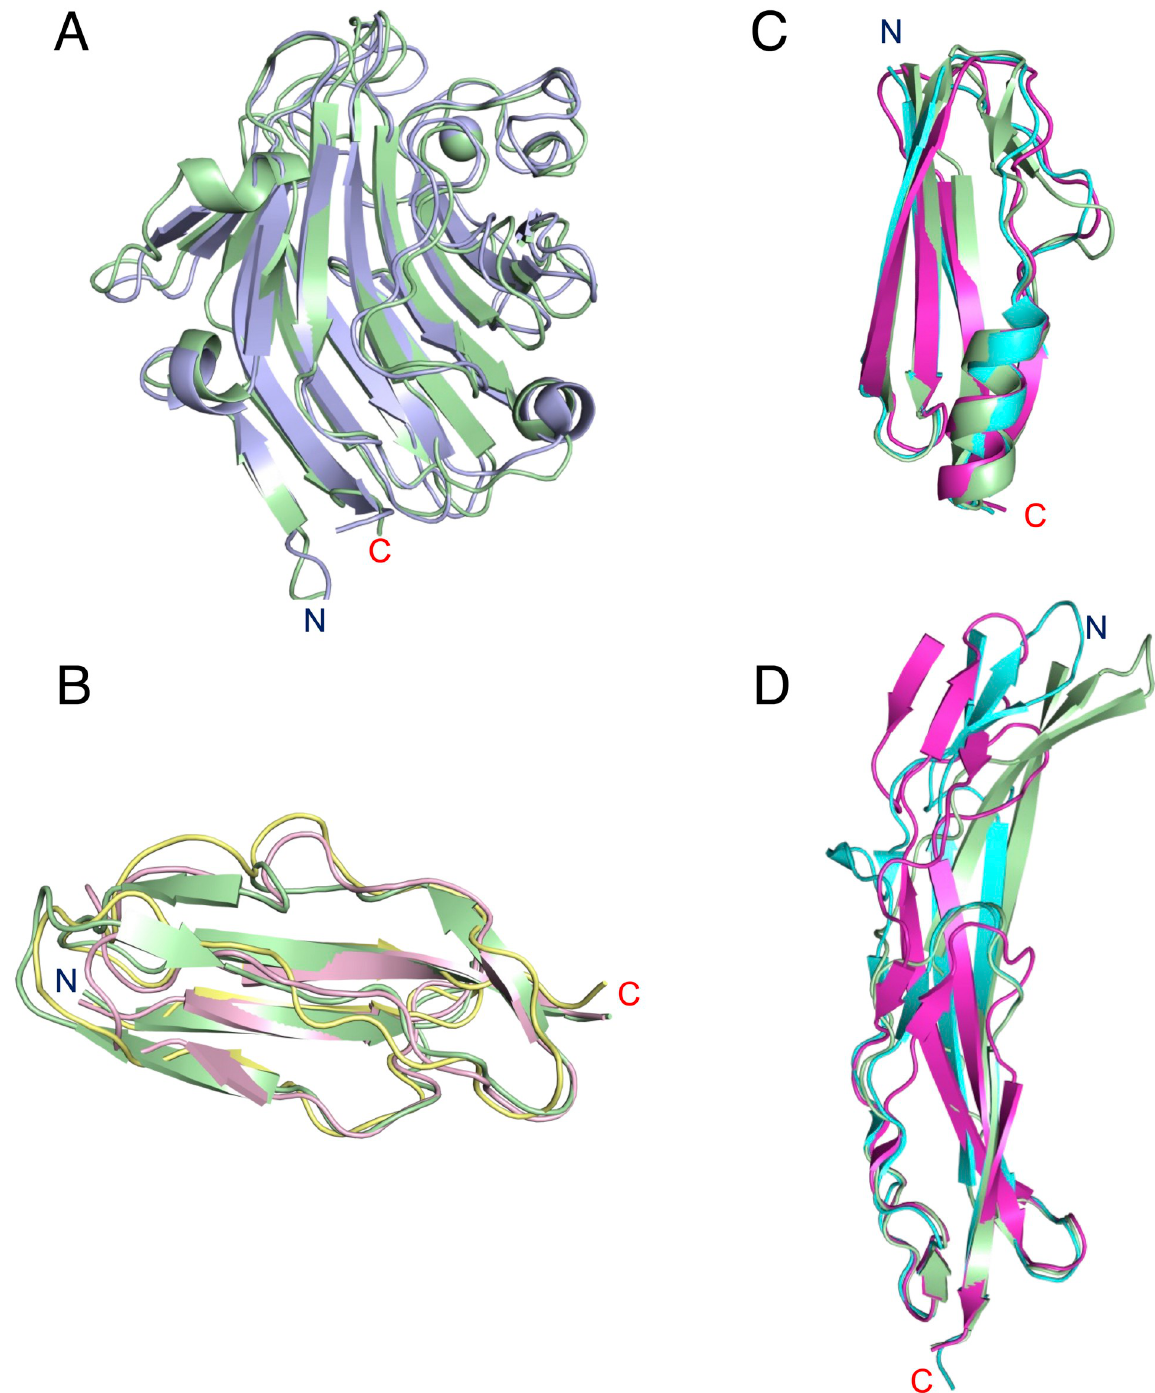
Fig 4. Comparison of YwfG domain structures. (A) Superimposed ribbon models of the Lec domain of YwfG (green) and Staphylococcus aureus SraP (light blue, PDB code 4m01). (B) Superimposition of the Mbp domain structures of YwfG (green) and L . monocytogenes Imo0835 (yellow, PDB code 2kvz; pink, PDB code 2kt7). Superimposition of the (C) Sub-N and (D) Sub-C structures of YwfG MubR1 on the B1 and B2 subdomains, respectively, of L . reuteri MubRV (cyan, PDB code 4mt5) and MubR5 (magenta, PDB code 3i57).